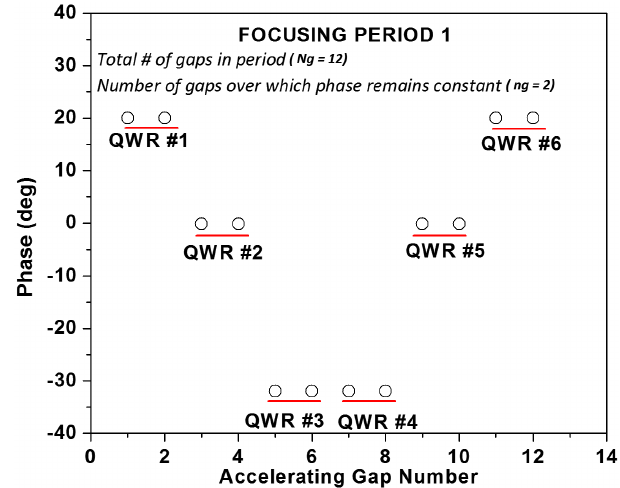
FIG. 2. Square-wave law variation for first focusing period with total number of accelerating gaps ( N constant for two gaps corresponding to single QWR ( n